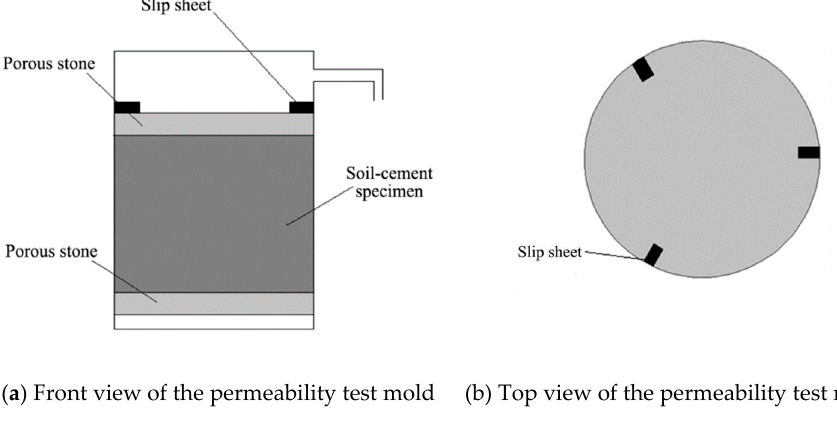
Figure 2. The modified permeability testing apparatus. 1: Air bump; 2: Pressure gage; 3: Pressure regulating valve; 4: Flume; 5: Water inlet; 6: Porous stone; 7: Soil-cement specimen; 8: Steel flake; 9: Water outlet; and 10: Burette.